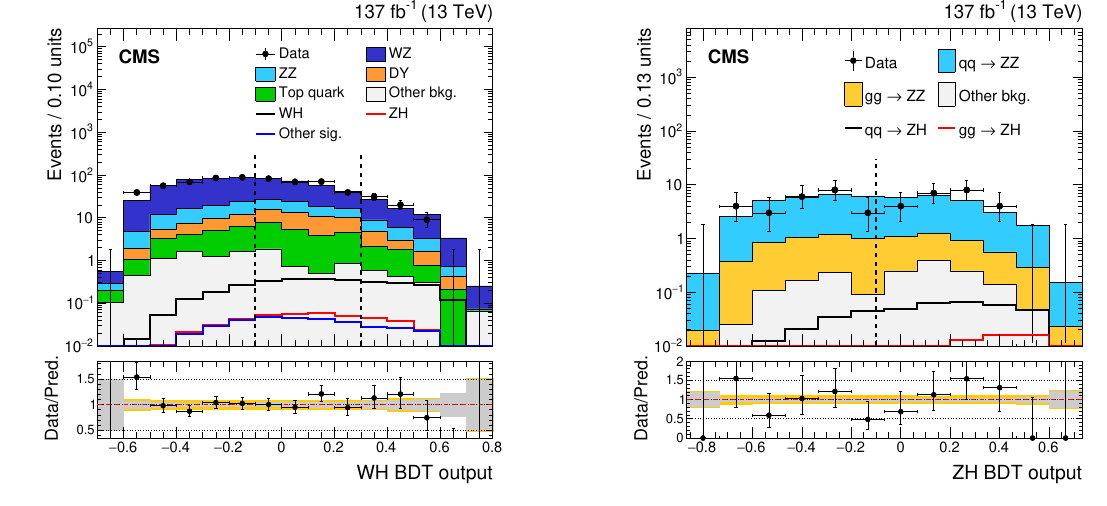
Figure 8 . The observed BDT output distribution in the WH (upper) and ZH (lower) categories compared to the prediction from the simulation of various SM background processes. Signal dis- tributions expected from different production modes of the Higgs boson with m overlaid. The description of the ratio panel is the same as in figure 4. The dashed vertical lines indicate the boundaries of the optimized event categories.